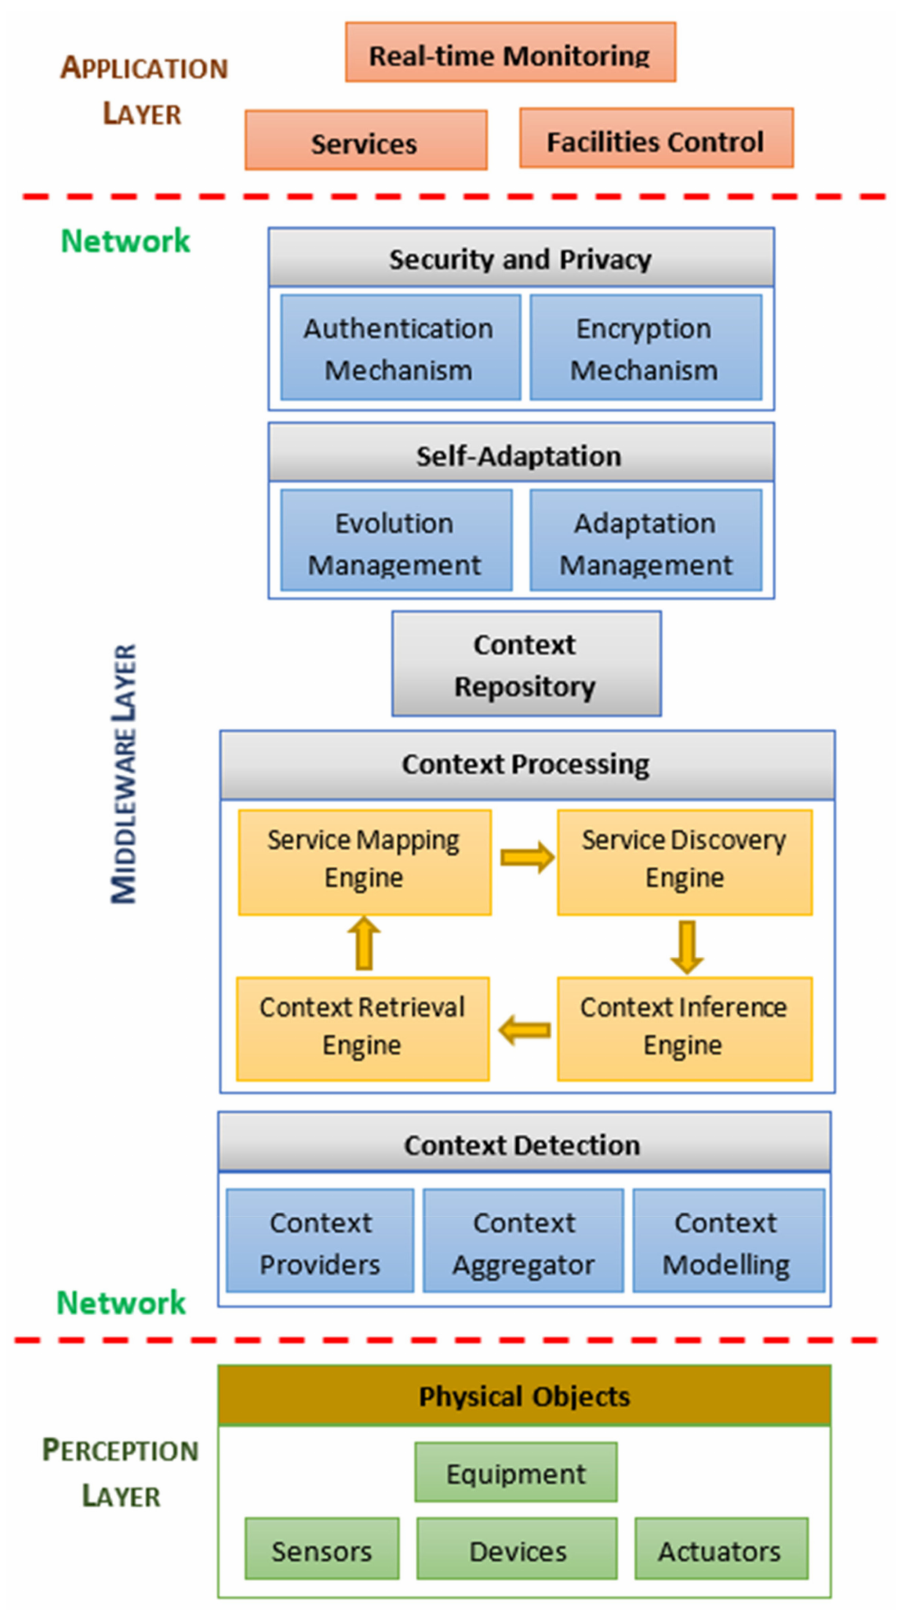
Figure 4. IFM system layered architecture